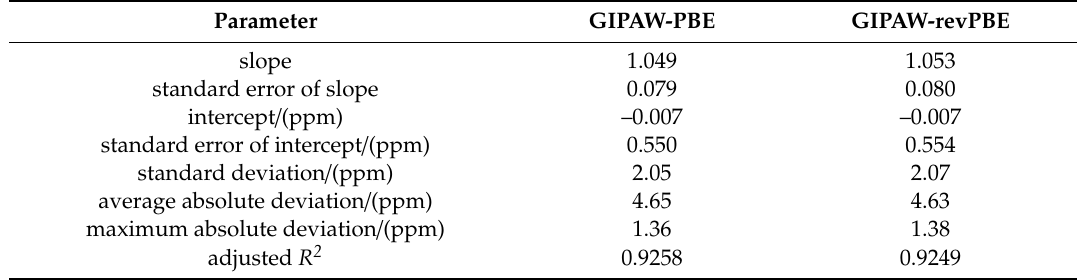
Table 3. Statistical evaluation of the agreement between the theoretical